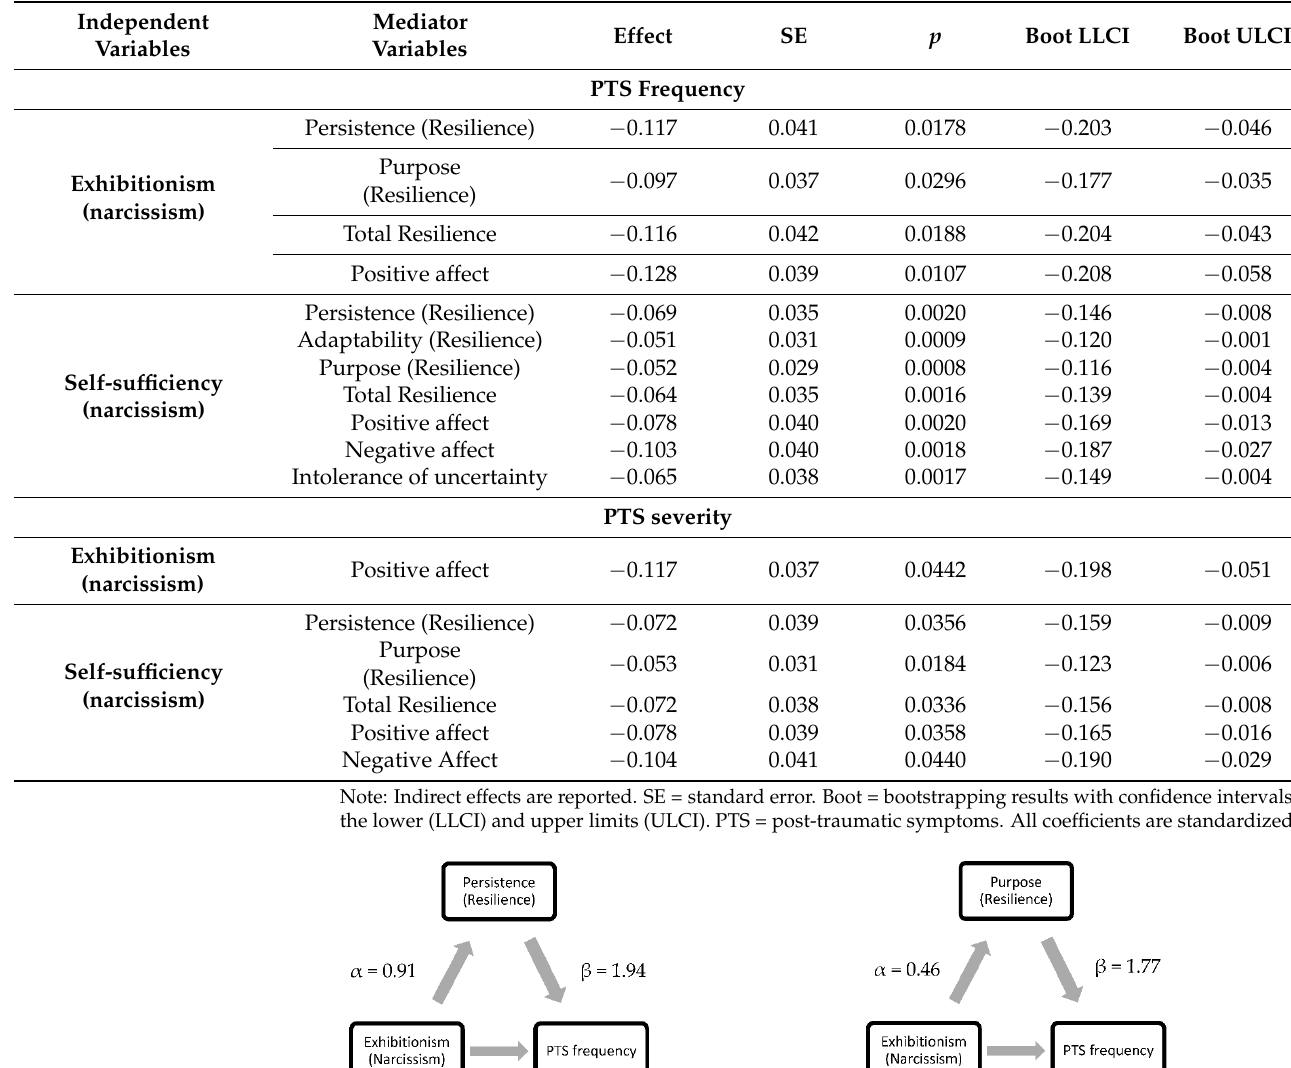
Table 4. Results of mediation analysis of the predictors of post-traumatic symptom frequency and severity.